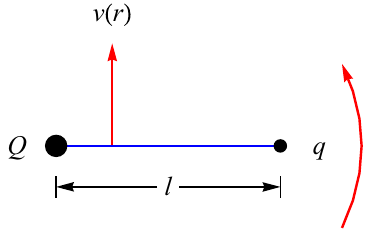
Fig. 1 The schematic diagram for depicting the string connecting heavy and light quarks at the ends and rotating around the heavy quark. A heavy quark is fixed at one